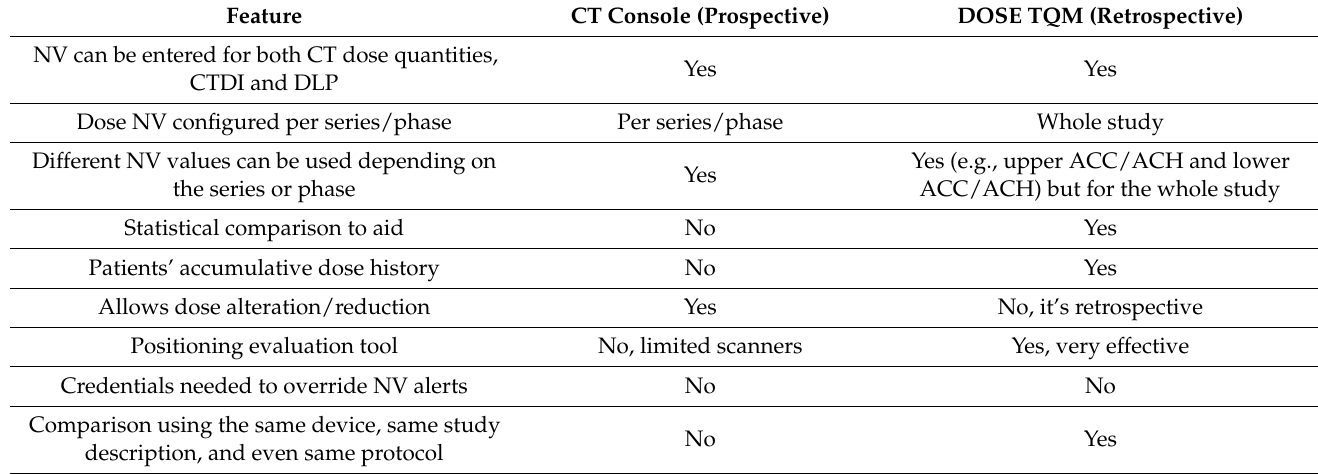
Figure 1. Demonstrates the key differences between the dose configuration setup for CT Abdomen/Pelvic + Contrast in a ( a ) prospective tool (CT system console) and ( b ) retrospective tool (DOSE TQM). a and b are screenshots taken straight from the CT system console and DOSE TQM, respectively. Table 1. Summary of feature differences between the CT console (prospective) and DOSE TQM (retrospective) dose monitoring tools.